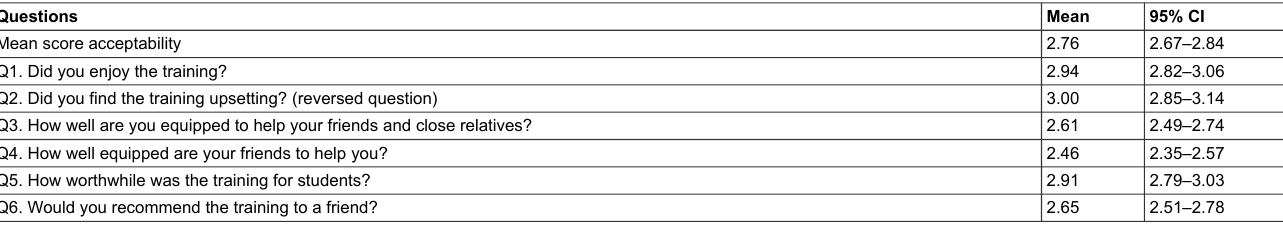
Table 4: Descriptive statistics and 95% confidence intervals (CIs) for acceptability